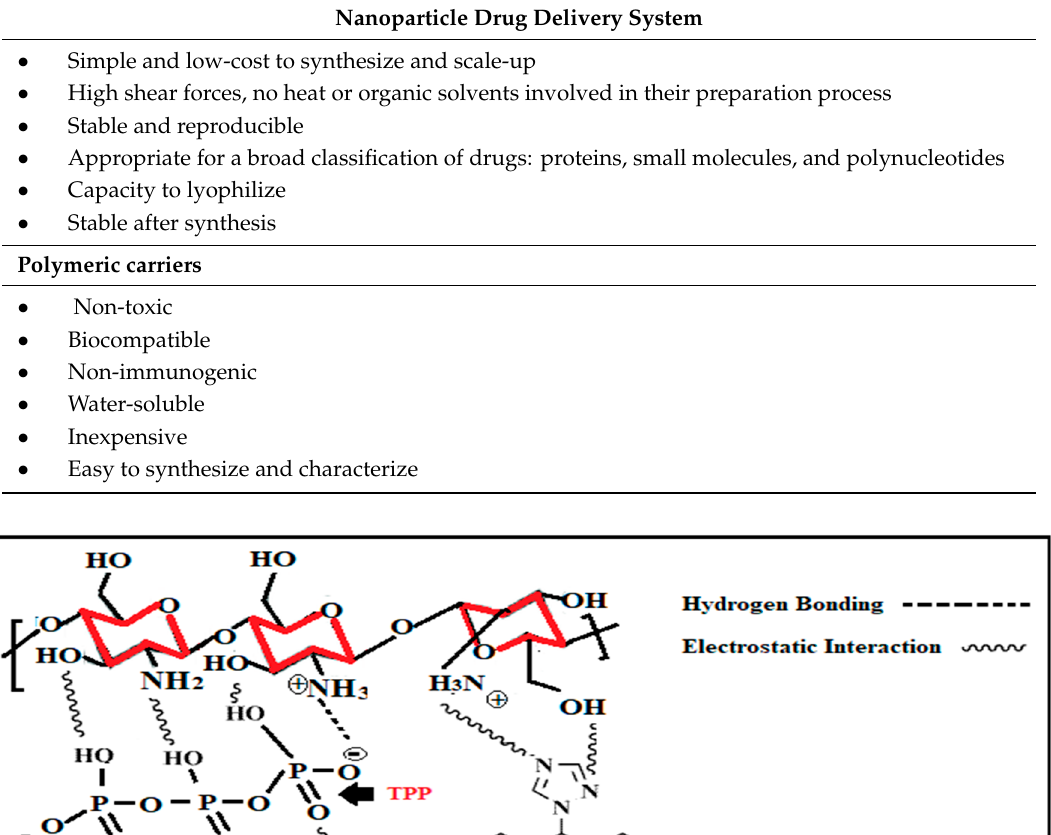
Table 1. Some ideal properties of polymeric nanocarriers [3].